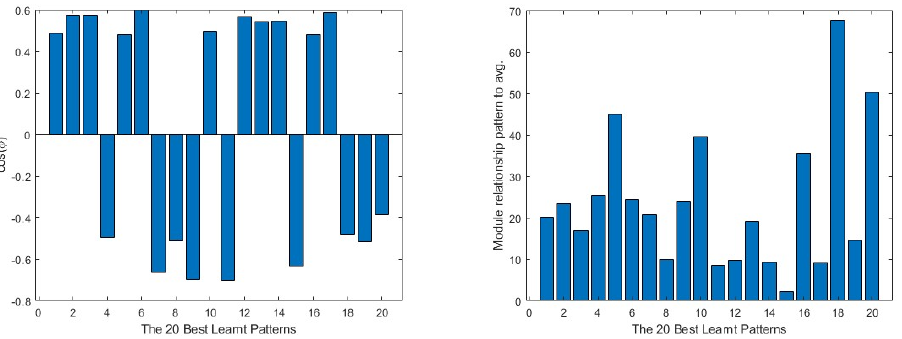
(cid:12) (cid:12) (cid:3339) ∂ Loss µ (cid:12) (cid:12) (cid:4698) relationship to the aver-